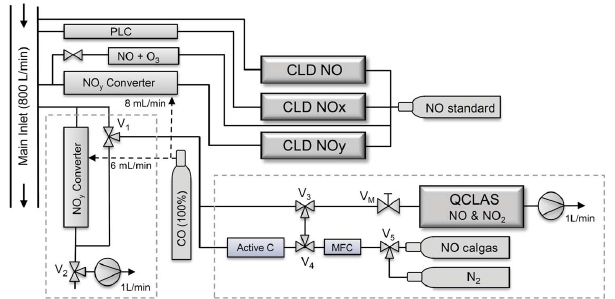
Fig. 3. Experimental setup at Jungfraujoch. The equipment within the dashed boxes was operated for a three-month period, while the other instrumentation is part of the permanent monitoring